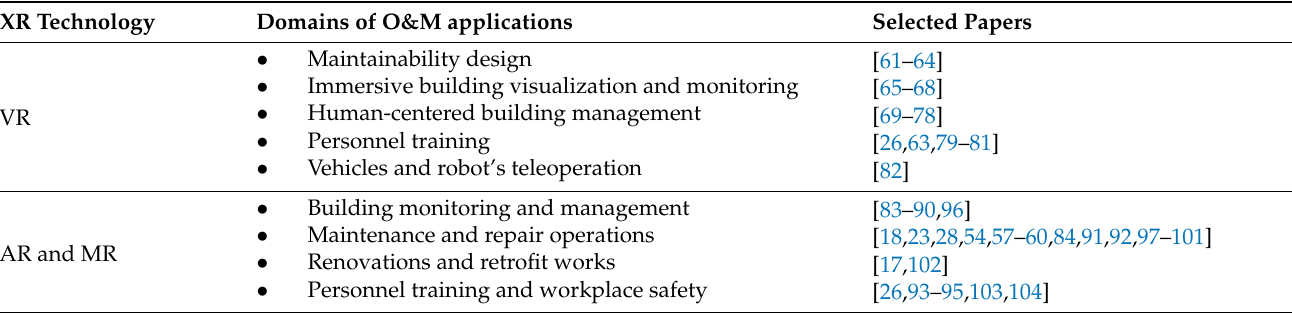
Table 3. Domains of O&M application of selected papers.